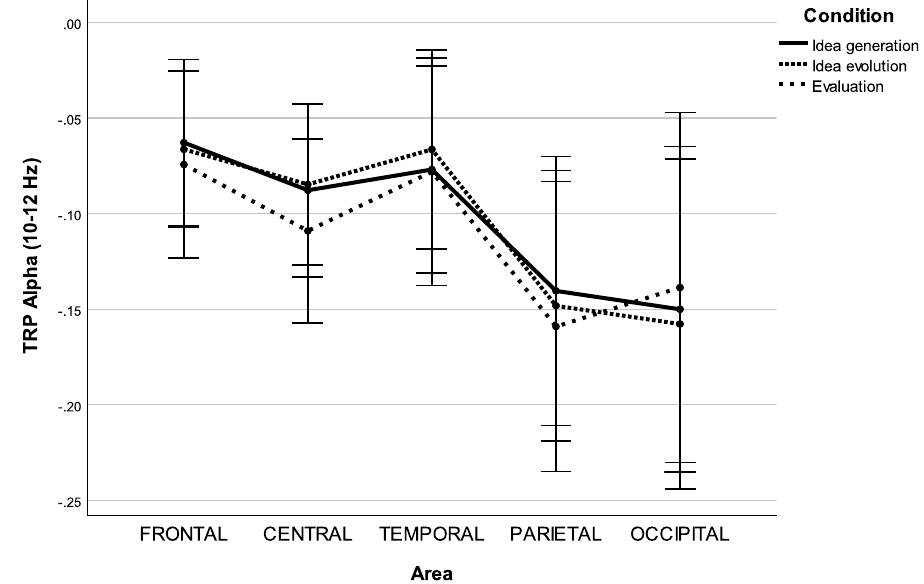
Figure 2. Task-related power in the upper alpha band during idea generation, idea evolution, and evaluation.